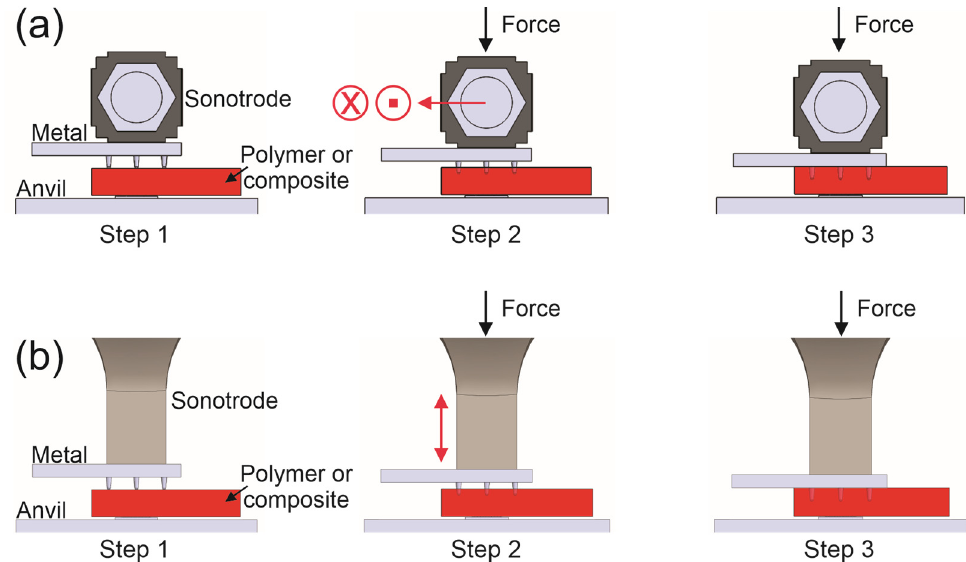
Figure 1. Schematic representation of U-Joining process steps when using ( a ) horizontal (Adapted with permission from [8], Elsevier, 2022) and ( b ) vertical mechanical vibration.